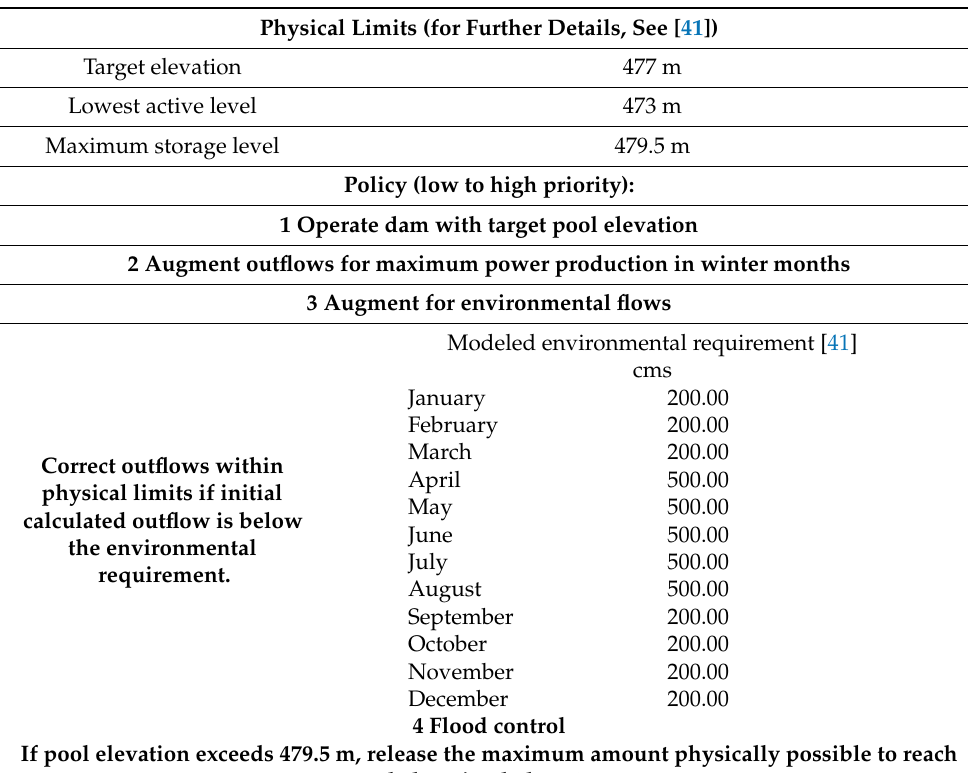
Table A1. Modelled characteristics of the Kapchagay dam.